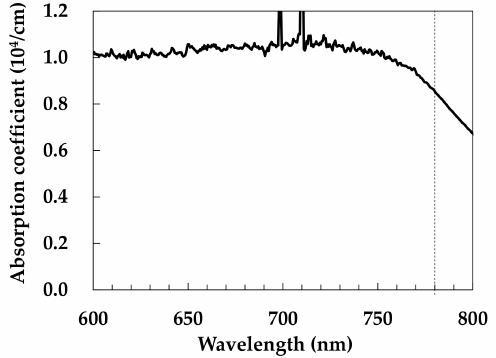
Figure 2. Absorption spectrum of the Co 3 O 4 nanoparticle ink film coated on the SiO 2 glass